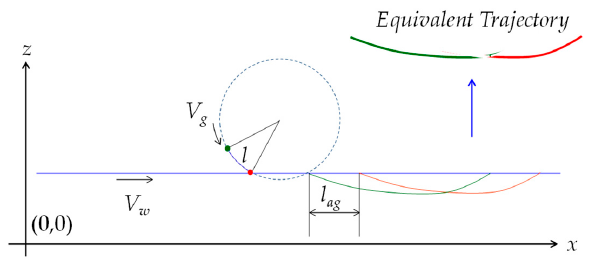
Figure 4. The concept of equivalent trajectory.